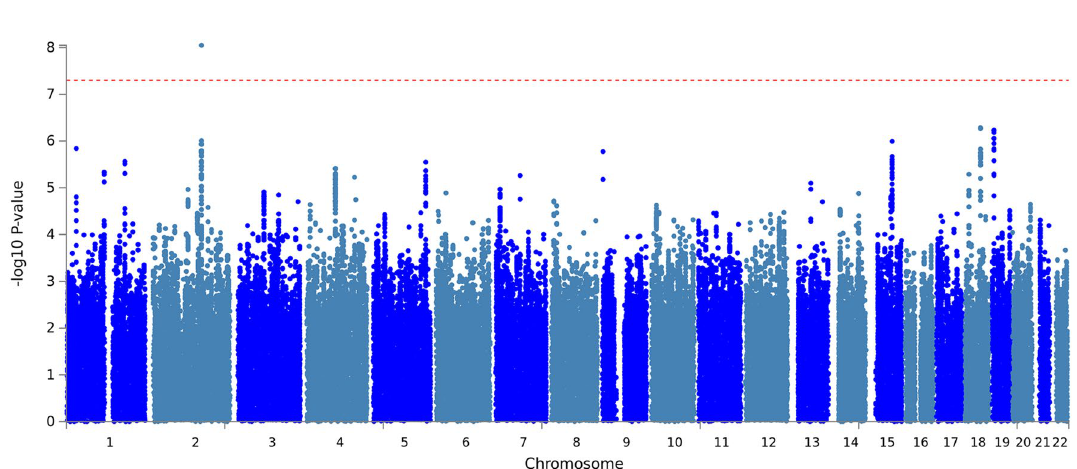
Figure 1. Manhattan plot of SNP-based GWAS for skeletal muscle index (SMI). The y-axis shows the -log 10 p-values for SNPs in the GWAS. The horizontal red dotted line represents the threshold of genome-wide significance ( p = 5 × 10 –8 ). The manhattan plot was generated using Functional Mapping and Annotation of Genome-Wide Association Studies (FUMA) v1.3.6 (https ://fuma.ctgla